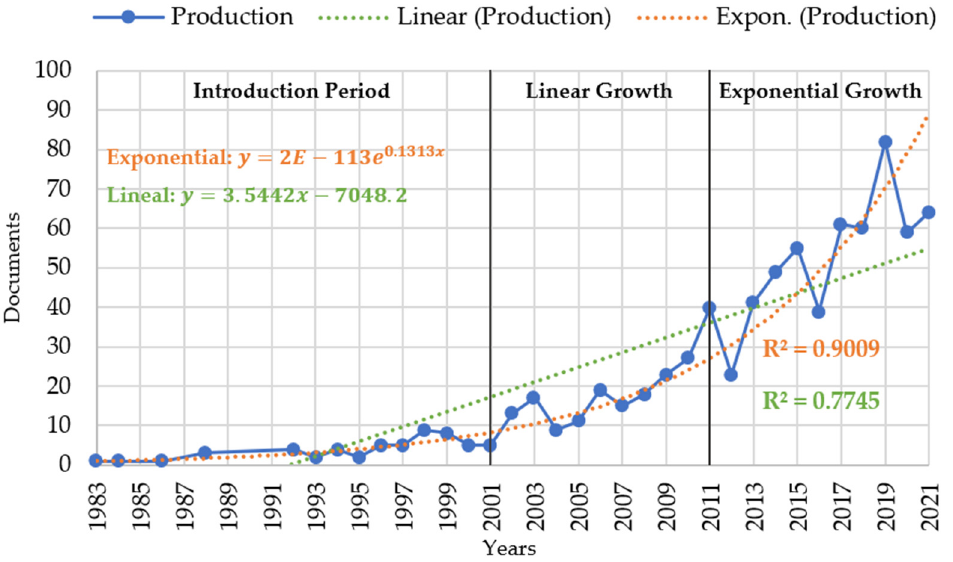
Figure 3. Scientific production of groundwater and life cycle relationship. Documents: 306 documents only from Scopus and 158 from WoS, and 316 from both databases.